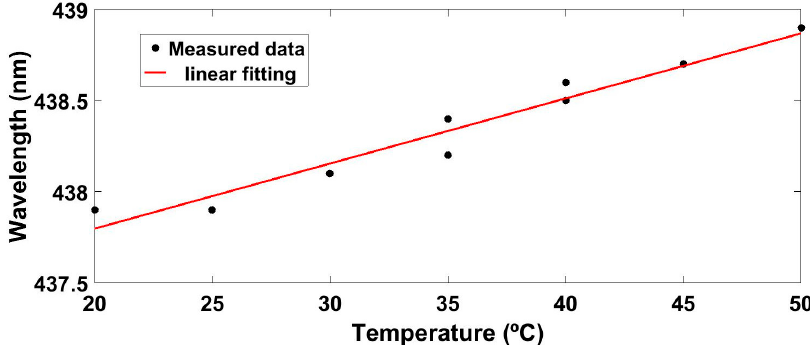
Figure 11. Sensitivity of the optical structure to temperature.